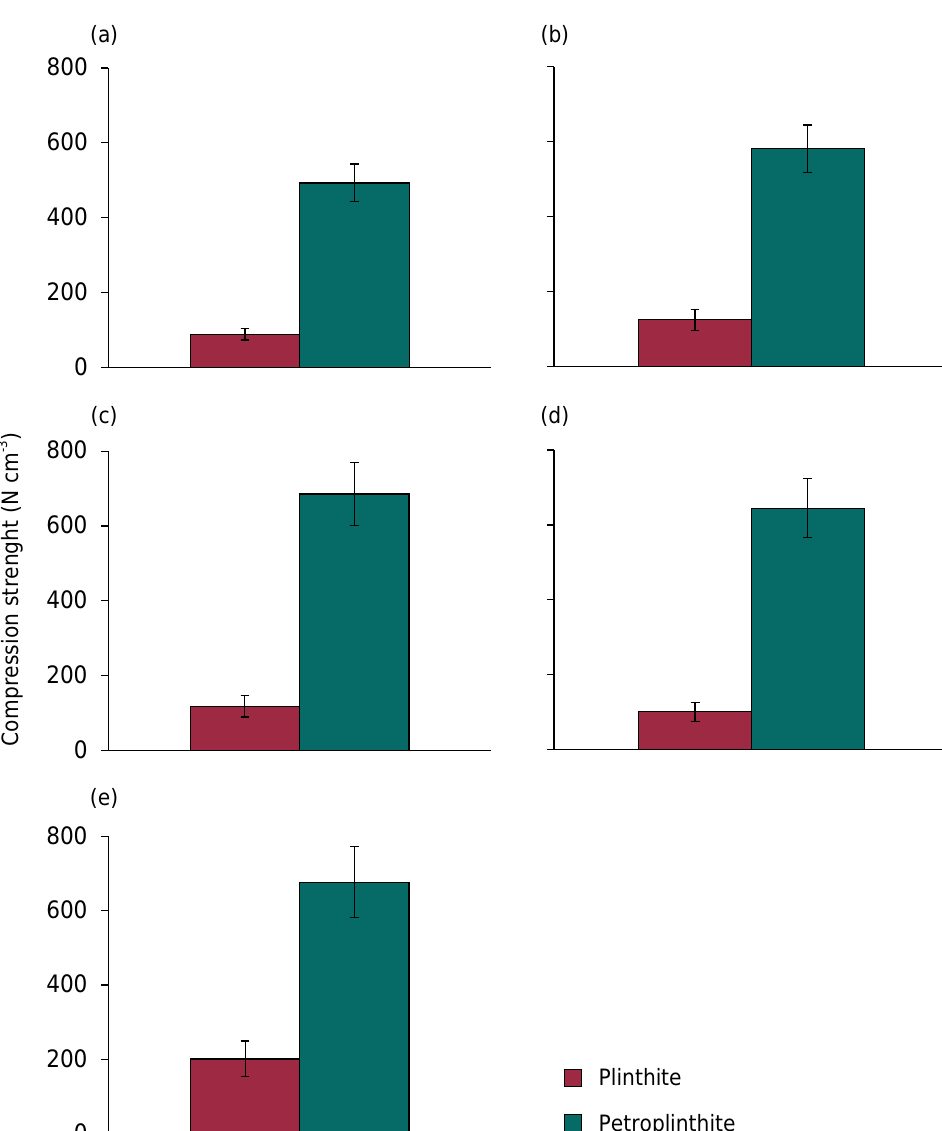
Figure 3. Mean value and standard error of the mean compressive strength of plinthite and petroplinthite of the studied profiles, immersed in distilled water (a), calcium carbonate (b), sodium hydroxide (c), sodium hydroxide + sodium hexametaphosphate (d), and acid solution (e) (95 % confidence interval;